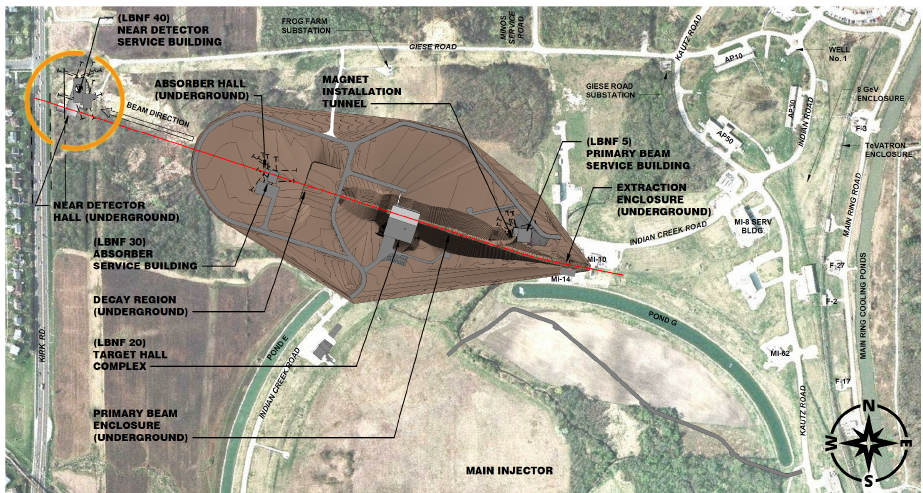
Figure 164. Birds-eye view of the future LBNF/DUNE construction site. The Near Detector cavern will be located at the west-most boundary of Fermi National Lab.